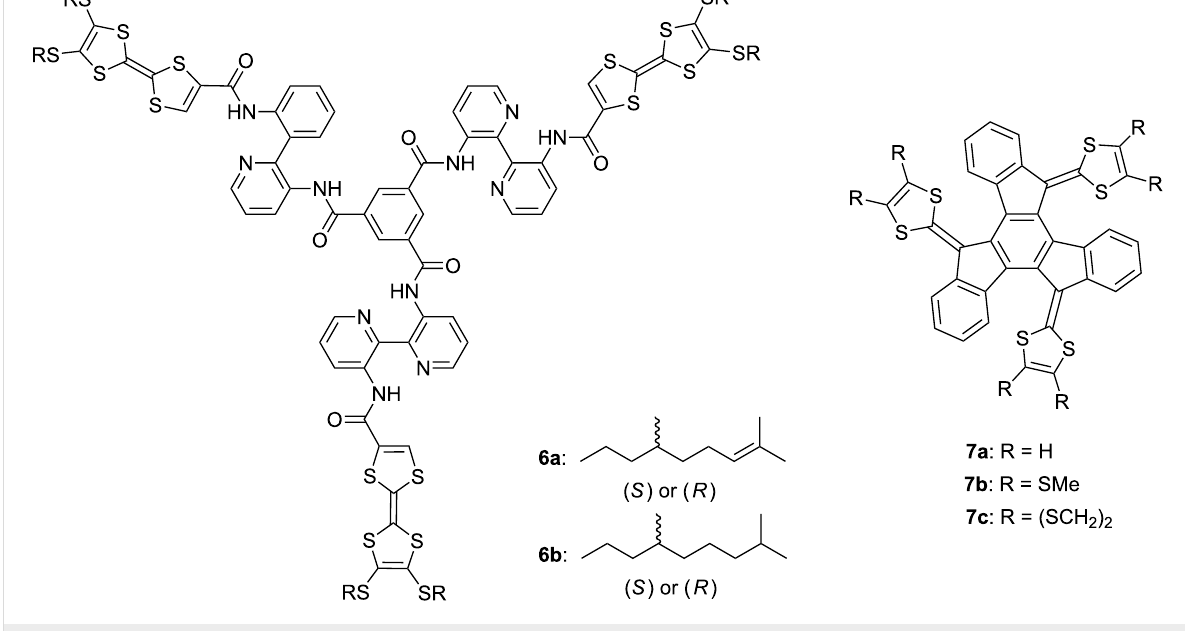
Figure 3: C 3 -symmetric TTF derivatives 6a,b and 7a–c .